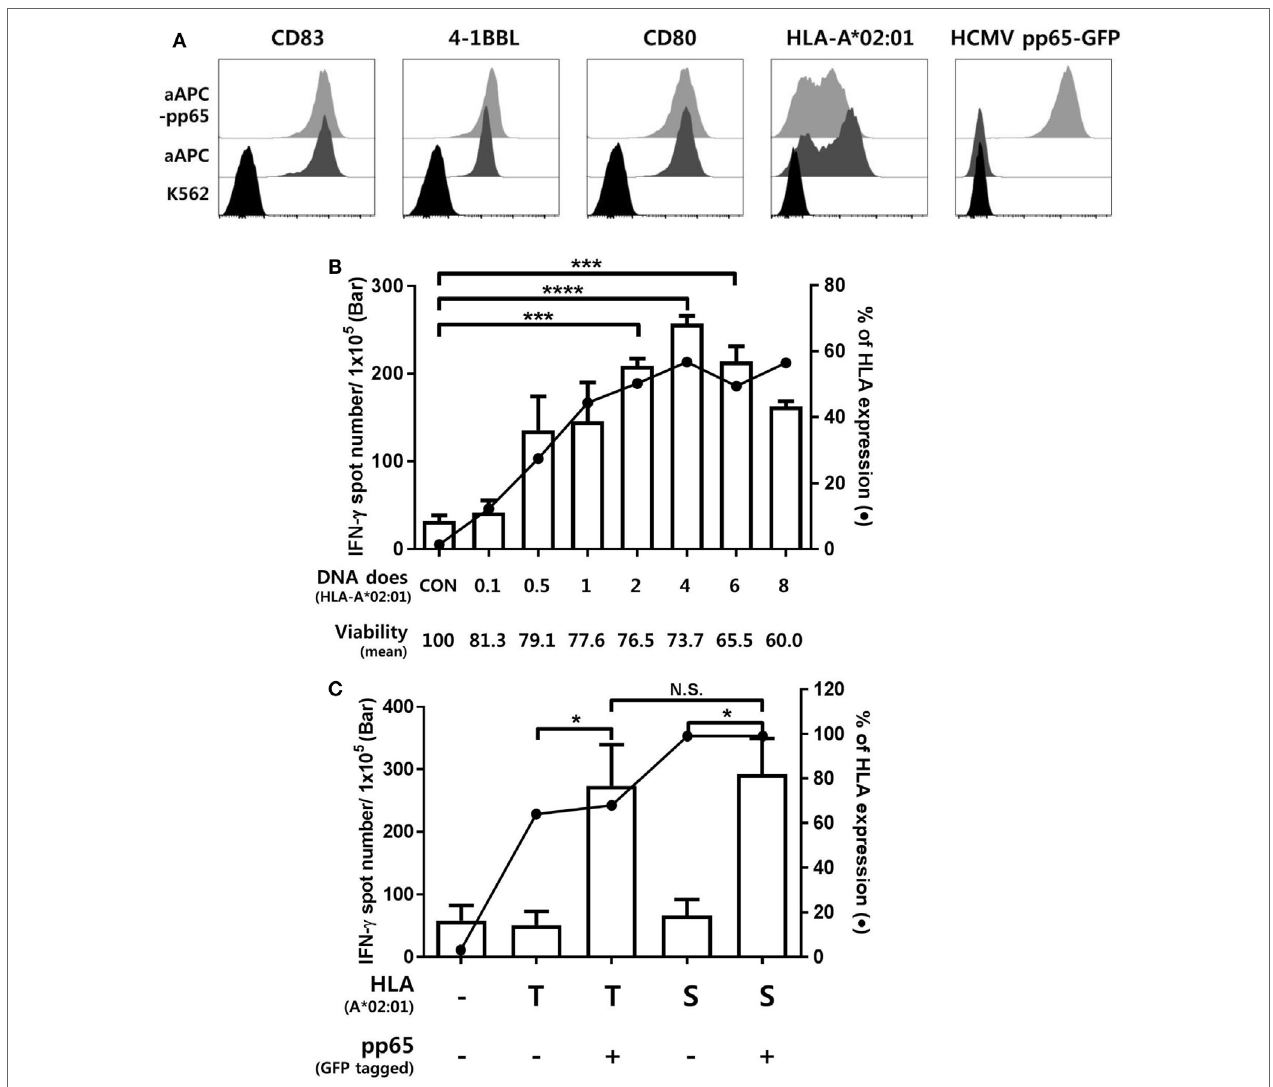
FigUre 1 | Establishment of an artificial antigen­presenting cell (aAPC) system to detect cytomegalovirus (CMV) pp65­specific CD8 + T cell responses restricted by a single human leukocyte antigen (HLA) class I allotype. (a) Establishment of aAPCs expressing CD83, 4­1BBL, and CD80, and aAPC­pp65 expressing CMV pp65 from the K562 cell line. To detect the CD8 + T cell response to CMV pp65, aAPC­pp65 were transfected with HLA­A*02:01 plasmid DNA. The expression of transferred genes was assessed by flow cytometry. (B) Optimization of HLA class I gene transfection to detect CD8 + T cell responses. HLA­A*0201 plasmid DNA concentrations ranging from 0.1 to 8 µg were used for transfection in 1 × 10 6 aAPC­pp65. CD8 + T cells showing strong responses to pp65 (HD01) were cocultured with aAPC­pp65 for the interferon­ γ (IFN­ γ ) enzyme­linked immunospot (ELISPOT) assay. (c) Comparison of transient transfection with 4 µg of plasmid DNA (T) and stable expression with lentivirus vector (S) of HLA­A*02:01 in stimulating CD8 + T cells. CD8 + T cells (HD01) were cocultured with aAPC ( − ) and aAPC­pp65 ( + ) for IFN­ γ ELISPOT assay. Results represent the mean percentage of expression from three independent experiments with SD (bars). P values were calculated by 1­way ANOVA (* P < 0.05; ** P < 0.01; *** P < 0.001; **** P < 0.0001; N.S., not significant).